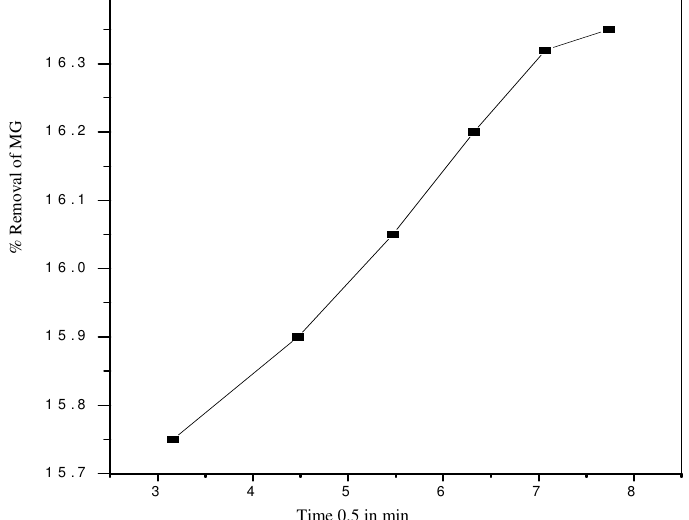
Figure 5. Intra-particle diffusion effect the adsorption of malachite green [M G] = 30 mg./L; temp = 30 o C; contact time = 60 min; adsorbent dose = 25 mg/50